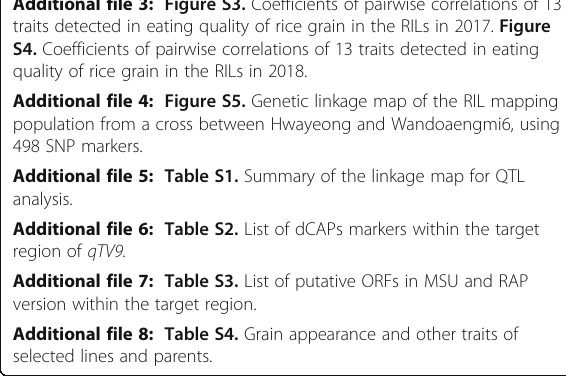
Additional file 3: Figure S3. Coefficients of pairwise correlations of 13 traits detected in eating quality of rice grain in the RILs in 2017. Figure